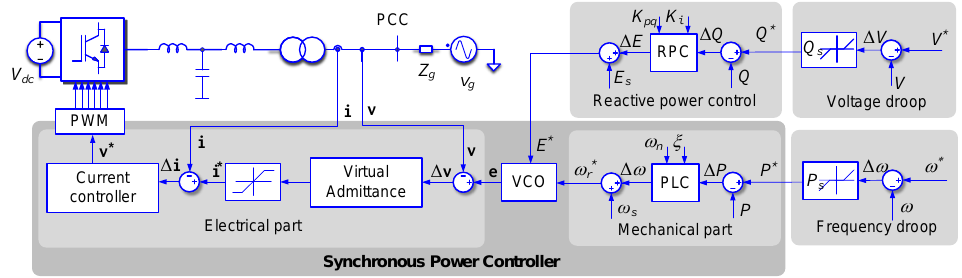
Figure 1. Control of grid-connected power converters based on the synchronous power controller (SPC).